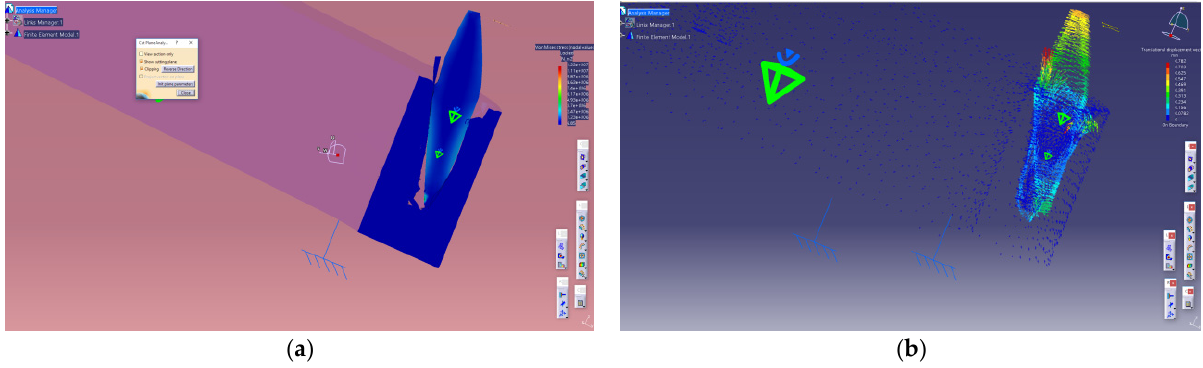
Figure 11. Lingualization of the LLI using a 3 N force: ( a ) von Mises tensions, no HBL; ( b ) tooth movement obtained, no HBL.